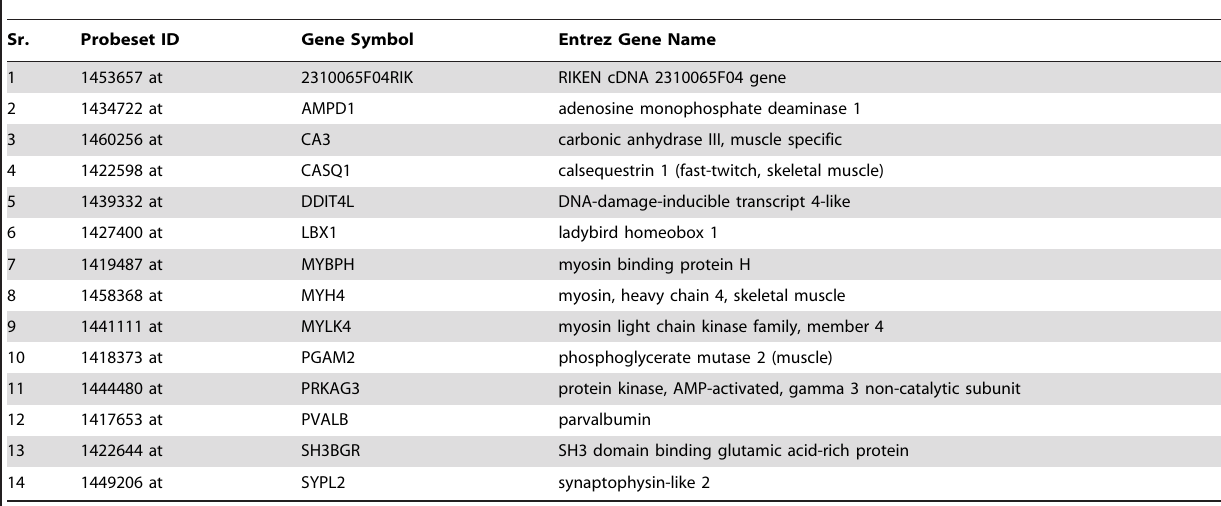
Table 13. Muscle 1 muscle 4 cluster